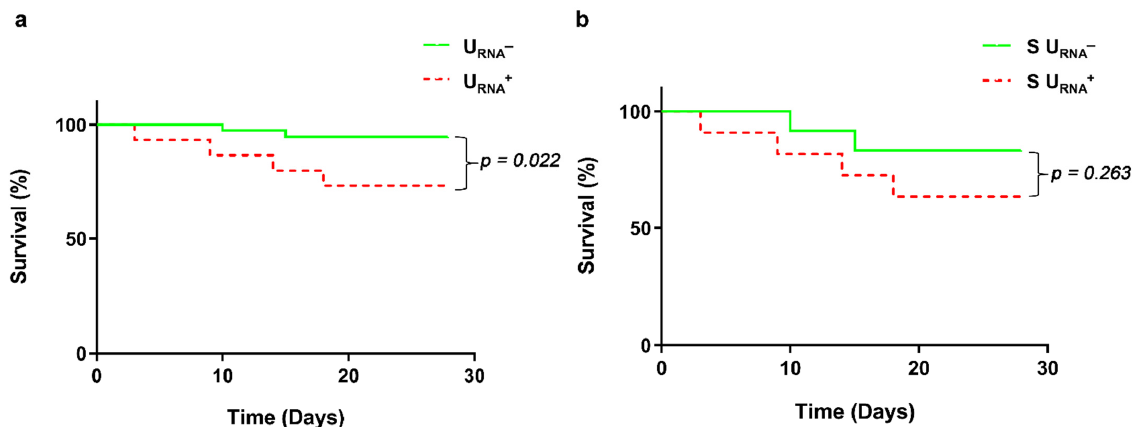
Figure 3. Survival curve for indicated groups of COVID-19 patients. ( a ) Survival curve for U RNA − and U RNA+ COVID-19 patients. Green solid line represents U RNA − patients, and red dotted line represents U RNA + patients. ( b ) Survival curve for server U RNA − (S U RNA − ) and S U RNA+ COVID-19 patients. Green solid line represents S U RNA − patients, and red dotted line represents S U RNA+ patients.